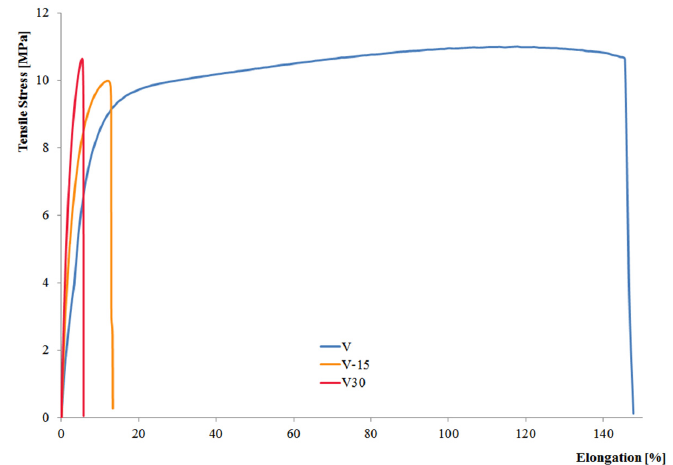
Figure 1. Comparison on stress ‐ strain curves for virgin BioFlex at different wood flour content.